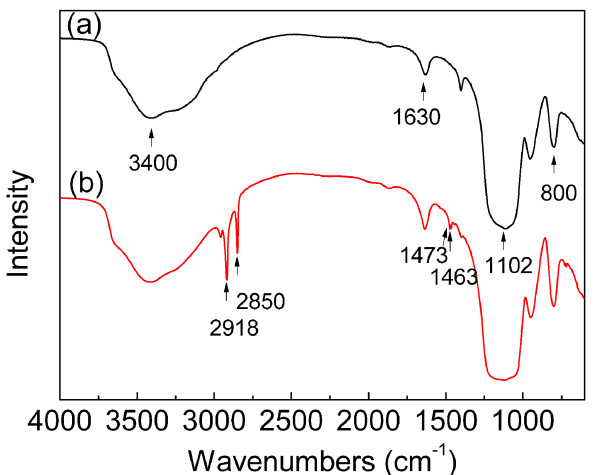
DRIFT spectra of Fe3O4@SiO2 (a) and DTH-Fe3O4@SiO2 (b).